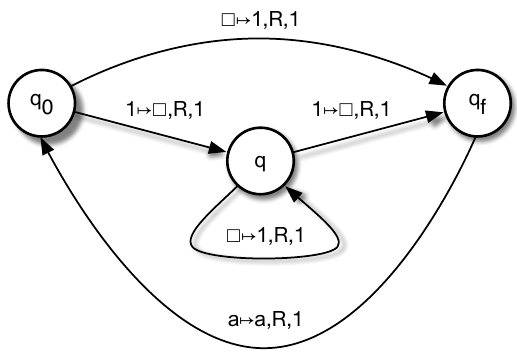
Figure 2. A reversible TM as a quantum Turing Machines (QTM) à la Bernstein and Vazirani.